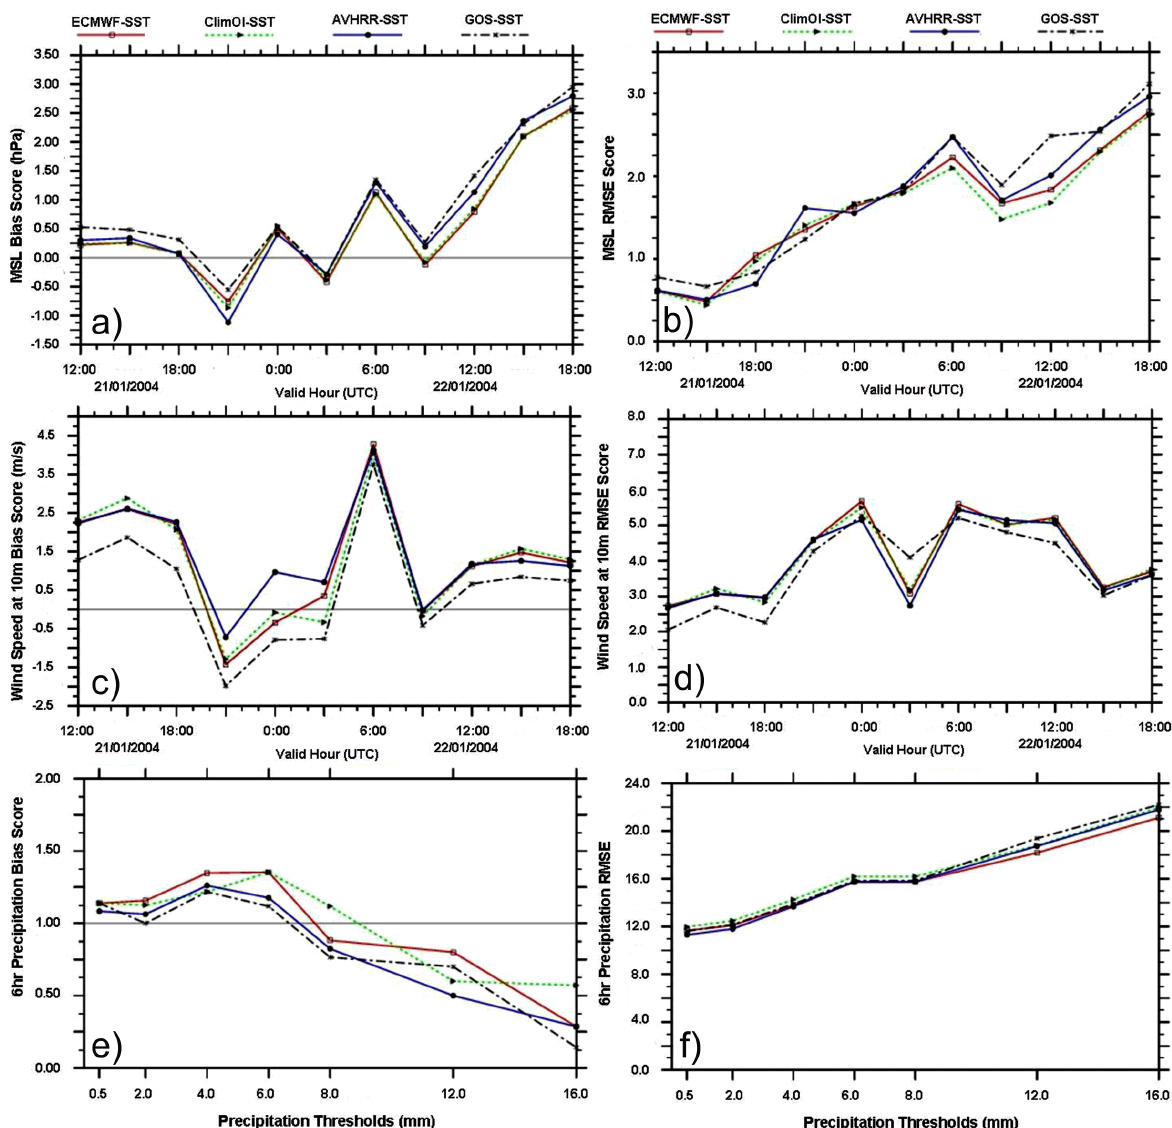
Fig. 9. Time plots of the bias scores ( a, c and e ) and RMSE scores ( b, d and f ) of the mean sea level pressure (hPa), the wind speed at 10m (ms − 1 ) and the 6-hourly accumulated precipitation (mm) respectively across the ECMWF-SST (solid red line), AVHRR-SST (solid blue line), ClimOI-SST (green dashed line) and GOS-SST (black dot-dashed line) experiments for the period 12:00 UTC, 21 January 2004 to 18:00 UTC, 22 January